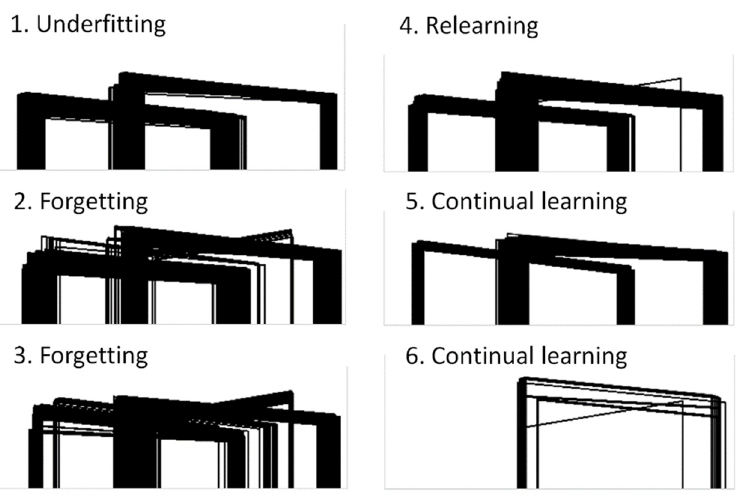
Figure 15. Obstacle silhouettes for which the 6 ML models used in the vertical test configuration failed the acceptance